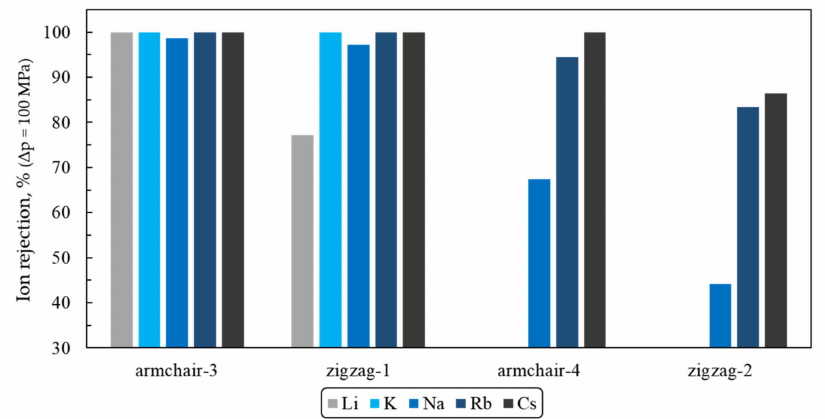
Figure 6. Estimates of cation rejection (pressure drop ∆ p = 100 MPa). The determination of Li + and K +